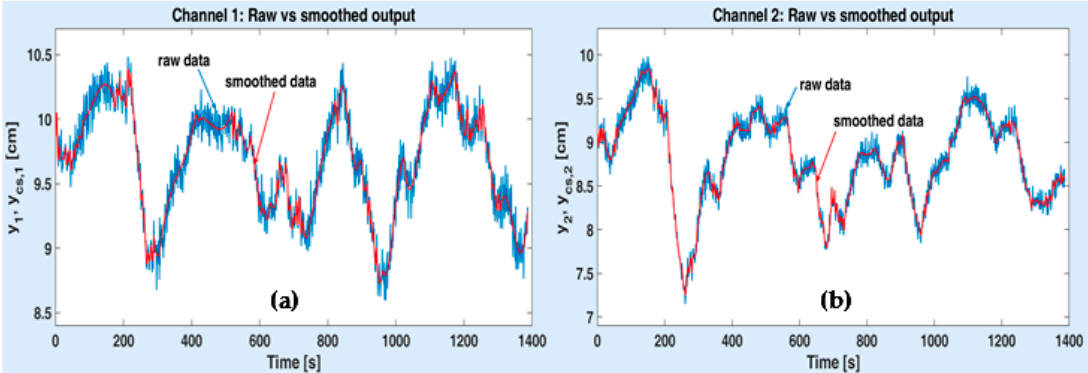
Figure 8. Raw measured and smoothed output signals obtained from channel 1 ( a ) and channel 2 ( b ). of ASTANK2 installation.